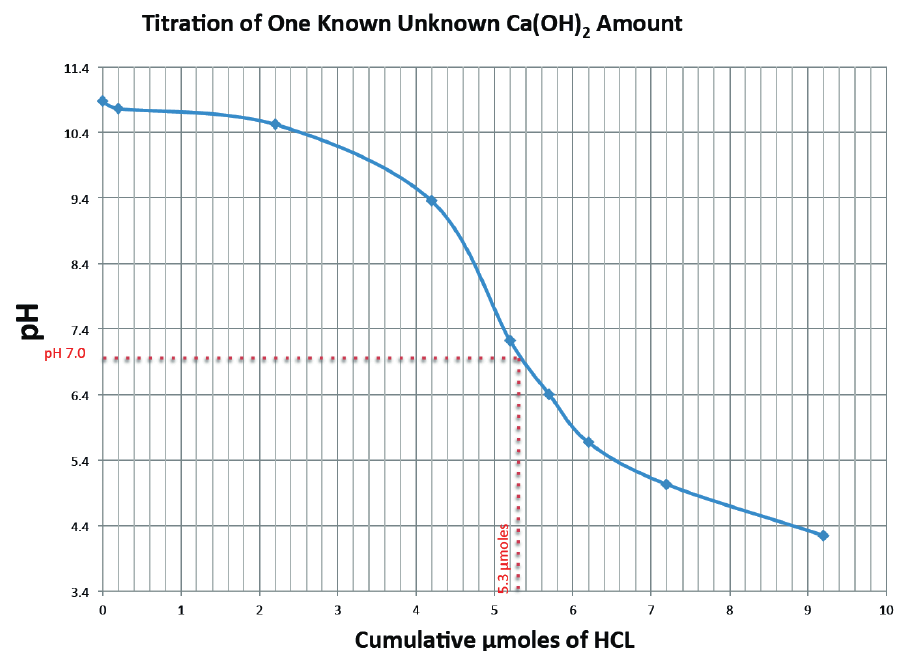
Figure 3- A titration curve was made from utilizing data points for an unknown sample titrated with HCL to pH 7.0. From the µmoles used at pH 7.0, we can determine the amount Ca(OH)